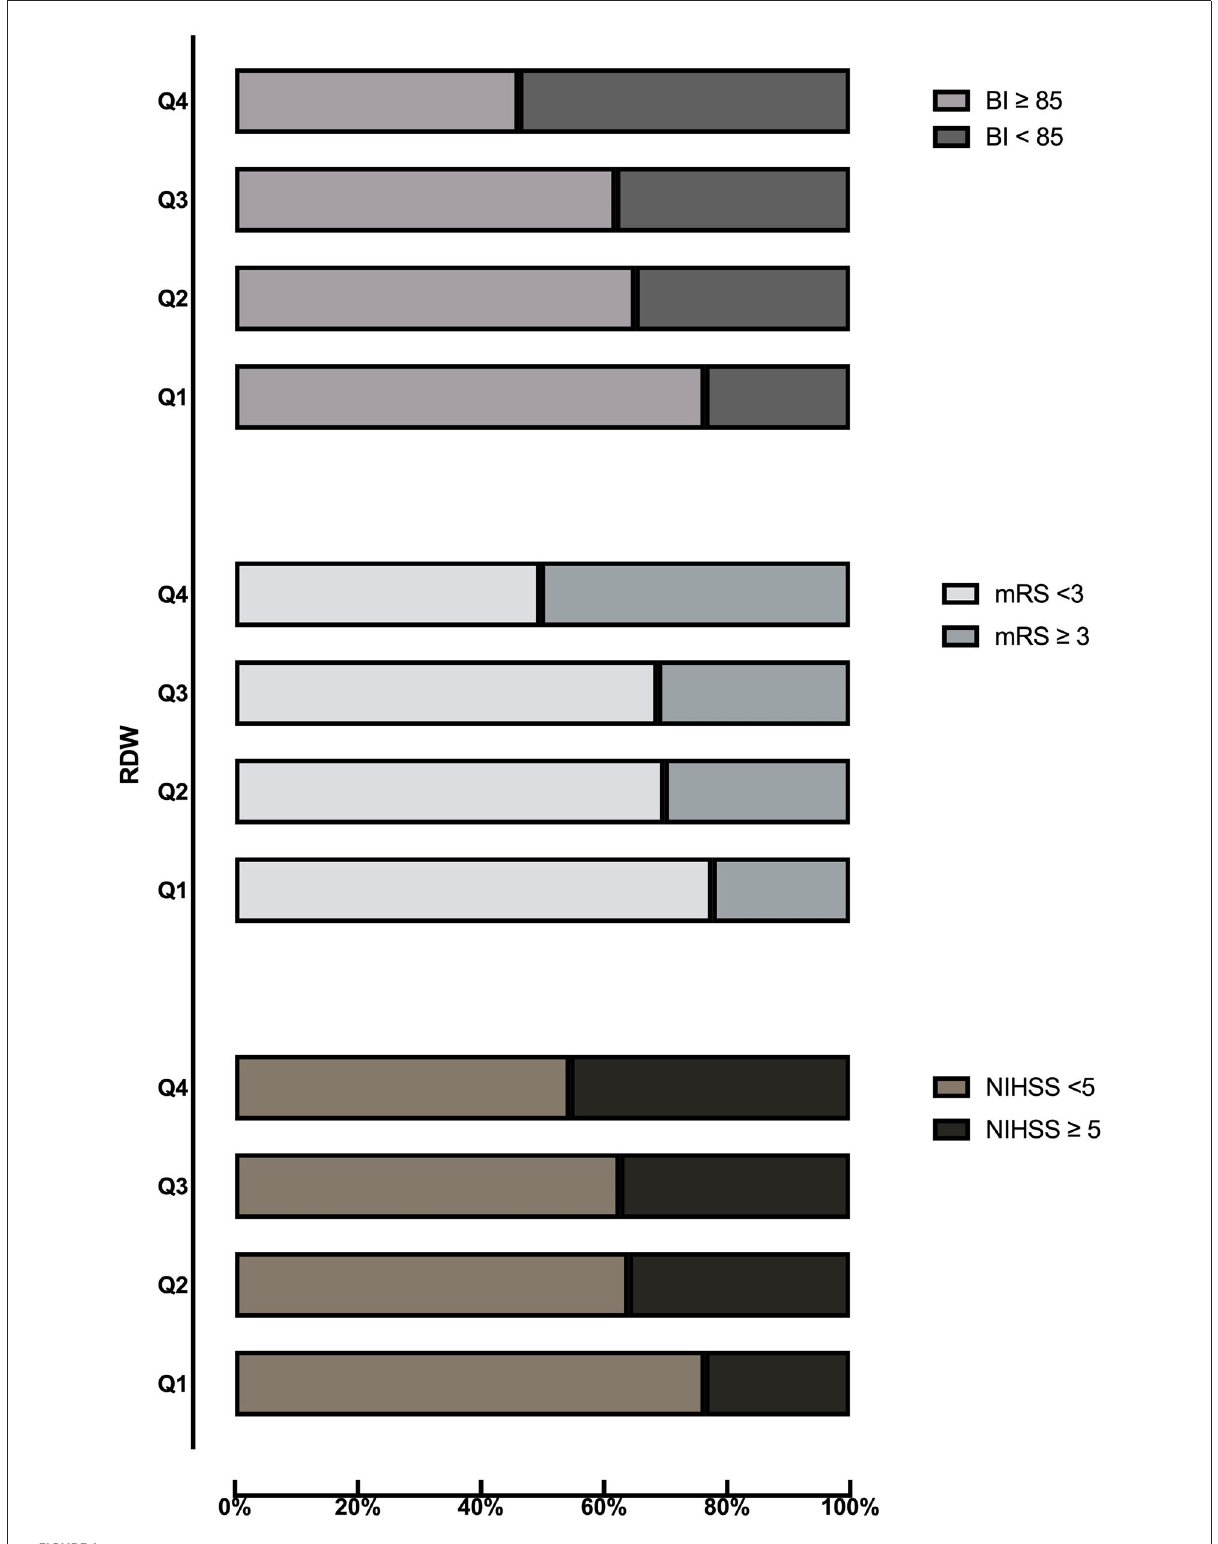
FIGURE1 Distribution of NIHSS score, mRS score, and BI score according to quartiles of RDW. BI, Barthel index; mRS, modified Rankin Scale; NIHSS, National Institutes of Health Stroke Scale; RDW, red cell distribution